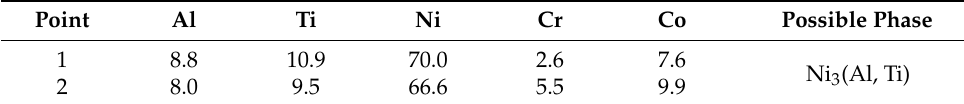
Figure 4. TEM-EDS result of phase with different morphologies: ( a 1 ) HADDF image of interface and corresponding elemental distribution maps of ( a 2 – a 6 ), ( b ) the enlarged view of Zone II, ( c ) the enlarged view of Zone III. Table 3. Composition of phases in bonding joints (at, %).